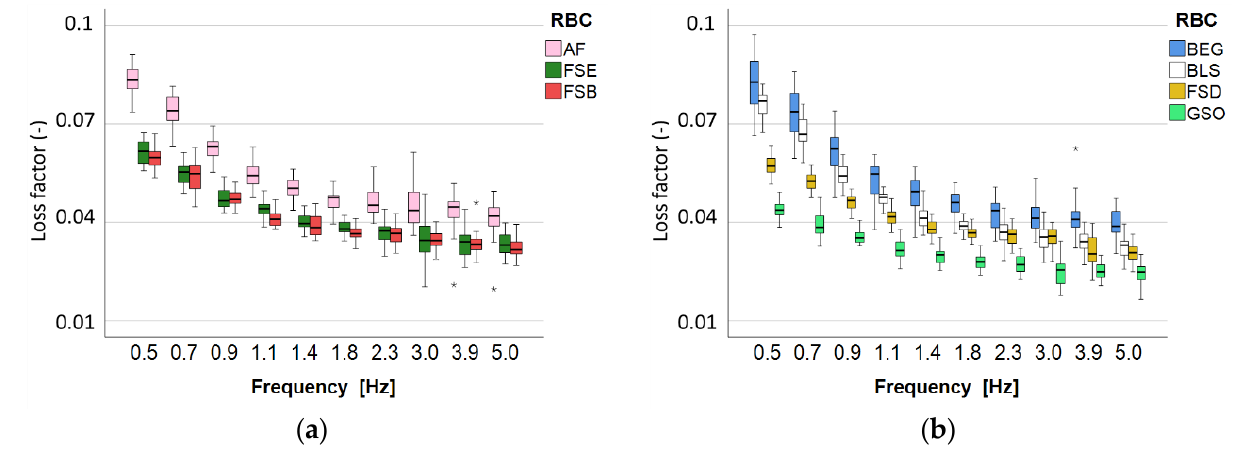
Figure 13. Dynamic mechanical analysis: loss factor as a function of material and frequency for ( a ) AF, FSE, and FSB, and ( b ) BEG, BLS, FSD, and GSO. Material abbreviation: AF = Admira Fusion; BEG = Brilliant EverGlow; BLS = Beautifil II LS; FSB = Filtek Supreme XTE Body; FSD = Filtek Supreme XTE Dentin; FSE = Filtek Supreme XTE Enamel; GSO = Grandio SO (asterisks indicate outliers). When assessed across the study design without differentiation within the materials, the effect of aging on the storage modulus is greatest ( η P2 = 0.869); followed by the H IT ( η P2 = 0.759) and the loss modulus ( η P2 = 0.205), while the effect on the loss factor is not significant ( p = 0.576). Table 3. Effect strength of the factors aging and frequency on each individual RBC, defined by the parameter η P2 . All effects are significant ( p <